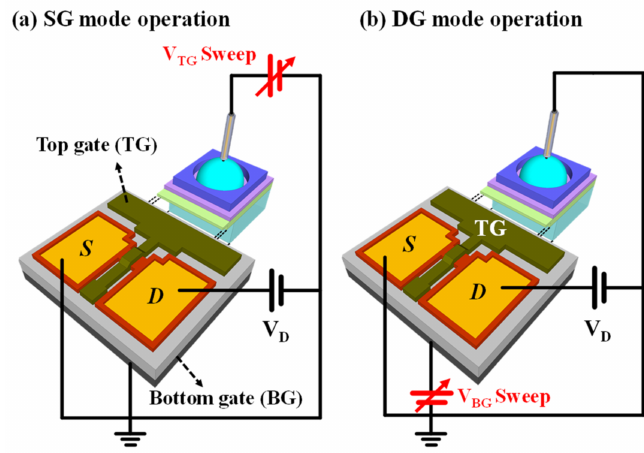
Figure 2. Simplified schematics of the DG ISFET sensor